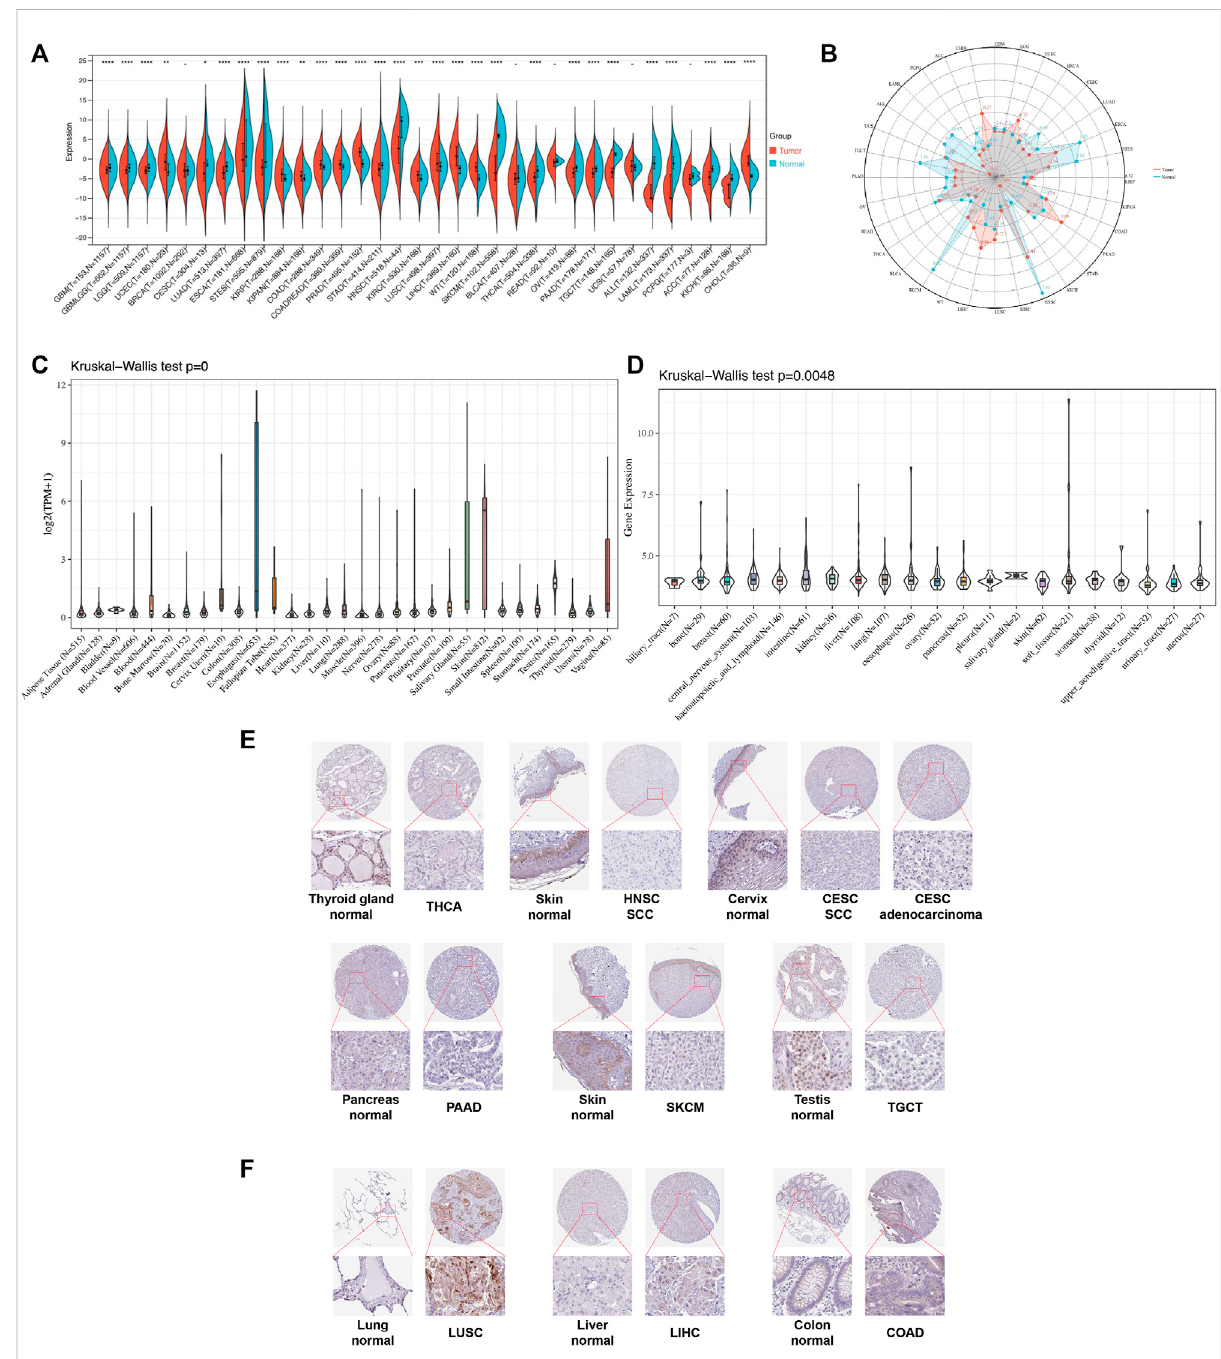
FIGURE 1 Pan-cancer TGM3 expression. (A) Pan-cancer expression of TGM3 between tumor tissues and normal tissues from TCGA, TARGET, and GTEx databases. * p < 0.05, ** p < 0.01, *** p < 0.001 and **** p < 0.0001. (B) Expression levels of TGM3 in tumor types from the TCGA database. Dots representthemeanofTGM3expressionineachtumortype. (C) NormalmRNAexpressionlevelsofTGM3indifferenttissuesfromtheGTExdatabase. (D) mRNA expression levels of TGM3 in different tumor cell lineages obtained from the CCLE database. (E) Lower expression of TGM3 at the protein level in tumor tissues of THCA, HNSC, CESC, PAAD, SKCM, and TGCT by IHC in HPA database (X50, X400). (F) Higher expression of TGM3 at the protein level in tumor tissues of LUSC, LIHC and COAD by IHC in HPA database (X50,